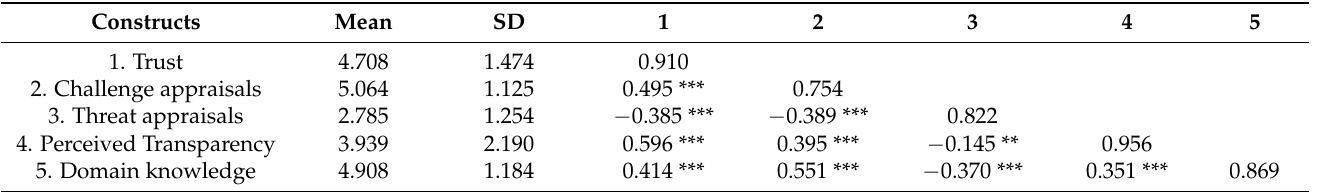
Table 3. The matrix of correlation